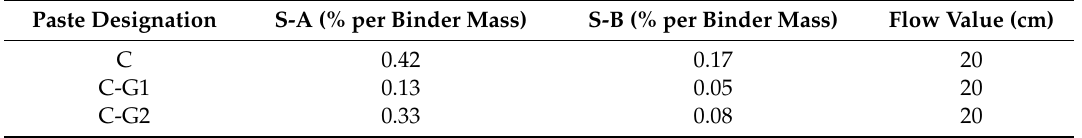
Table 4. Flow values and percentages of S-A and S-B in di ff erent pastes obtained from the flow